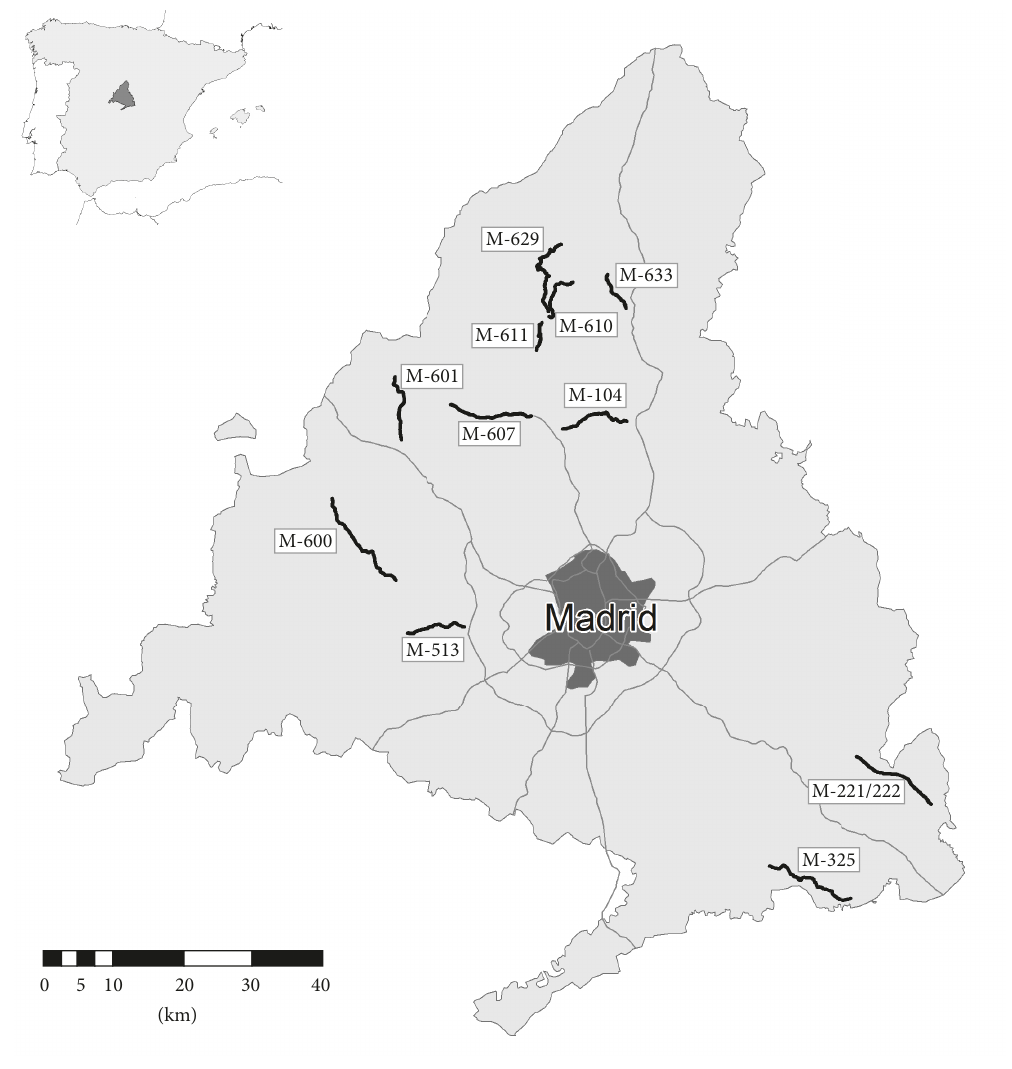
Figure 2: Location of selected highway